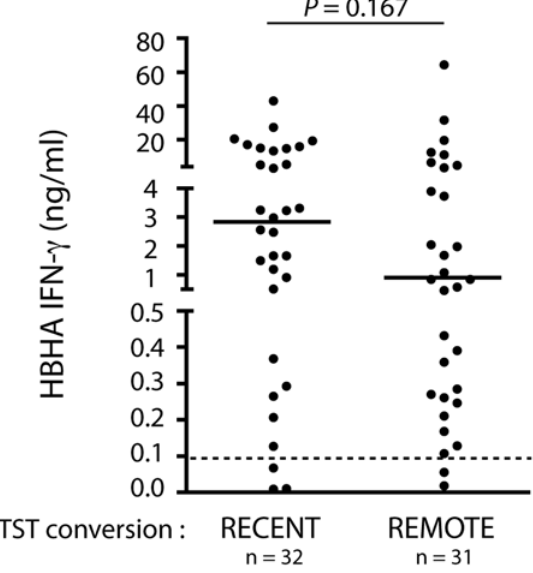
Figure 2. Comparison between the HBHA-induced IFN- c concentra- tions in recently and in remote M. tuberculosis infected LTBI subjects. Blood samples were collected from LTBI subjects during the first two years (recent) or after two years (remote) of their TST conversion. Their PBMC were in vitro stimulated with HBHA, and the IFN- c concentrations were measured in 96 h cell culture supernatants. No significant difference in the IFN- c concentrations measured in the two groups was noted. The horizontal dotted line indicates the positivity cut-off of the test, and the horizontal filled lines indicate the